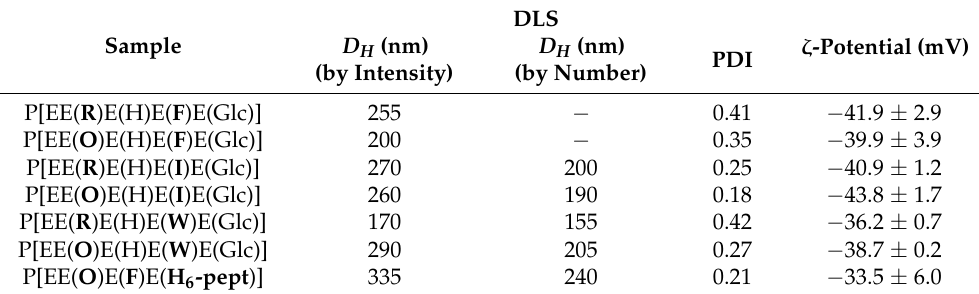
Table 3. Characteristics of the PTX-loaded nanoparticles (50 µ g of PTX/mg